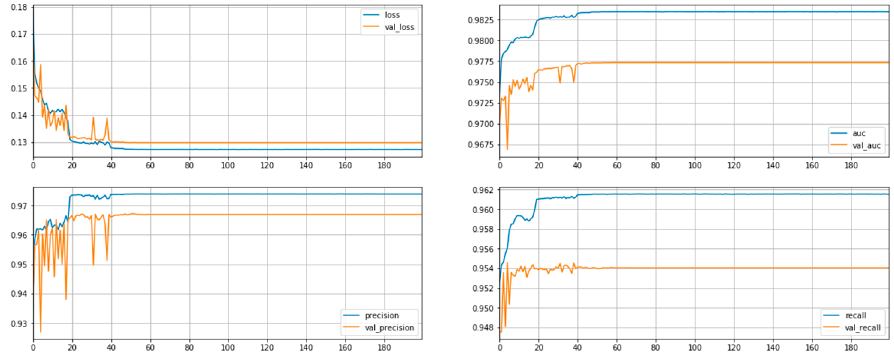
Figure 15. Learning curves of optimized model.